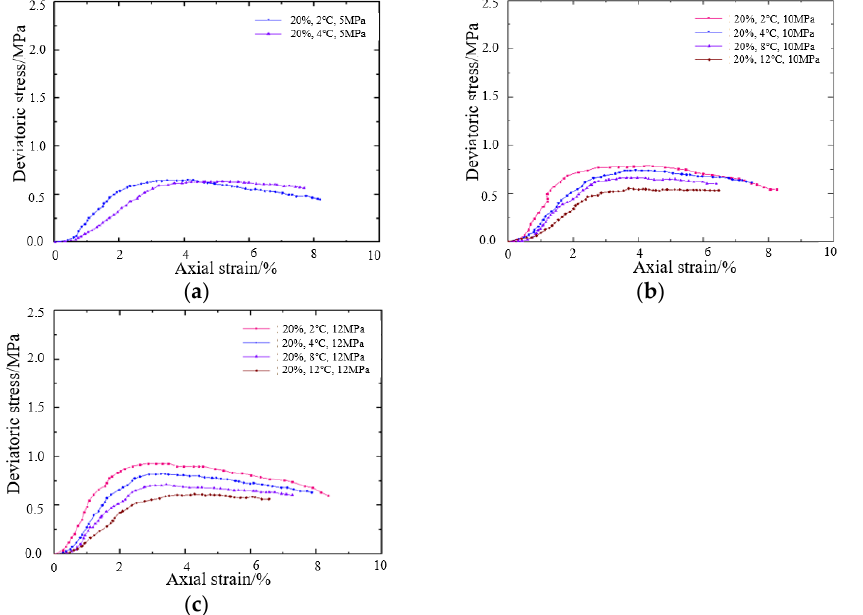
Figure 11. Core stress–strain curves at different temperatures (abundance 20%) ( a ) The test pressure is 5 MPa; ( b ) The test pressure is 10 MPa; ( c ) The test pressure is 12 MPa. The analysis of the graph indicates that the stiffness and strength of muddy silt hy-